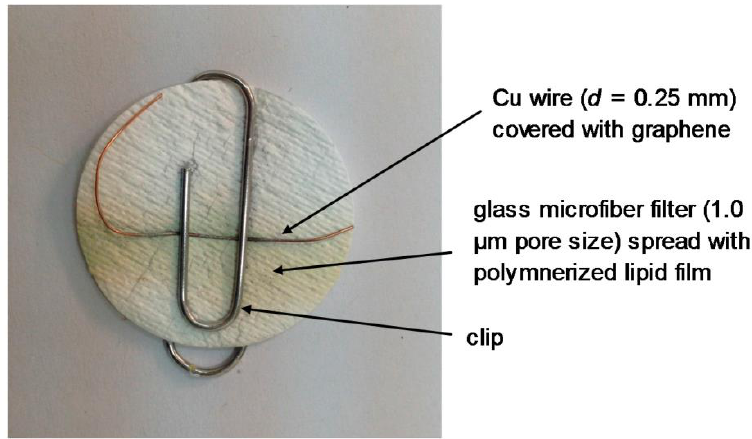
Figure 8. Picture of the lipid film device on graphene mini-electrode, which was used for the potentiometric detection of urea (reprinted from ref. [83]).